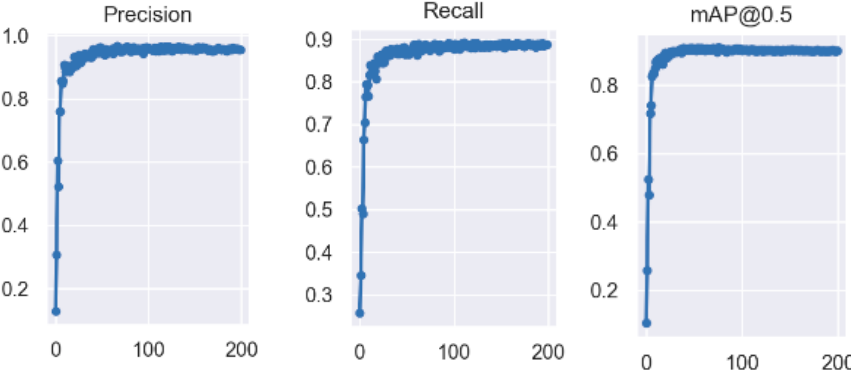
Figure 13. Prediction curve, Recall curve, and mAP value of the training results.